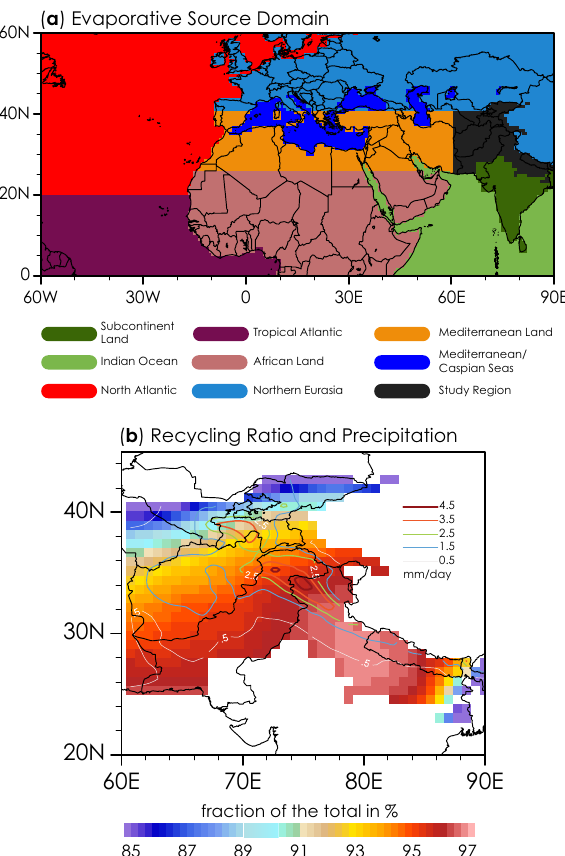
Fig. 1 The evaporative source region, seasonal (November – March) recycling ratio, and recycled precipitation. a The evaporative source region with its subdivisions. b Seasonal fraction (expressed in %) of moisture falling as precipitation at each grid cell that originated as evapotranspiration ( fi lled contours) over the evapora- tive source region (recycling ratio) and corresponding recycled seasonal precipitation (mm/day; line contours). This analysis shows an average of ERA5, MERR2, and ERAI from 1981 to